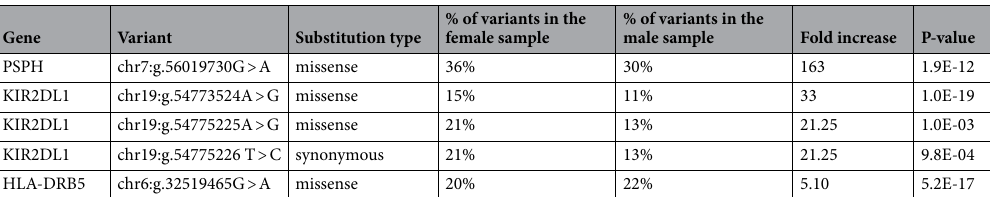
Table 1. Top 5 variants with the highest fold increase and statistical significance in the Serbian population sample compared to Europeans and their sex representation. Statistical significance was determined by the one-tailed Fisher’s exact test with total frequencies from all 1kGP populations and after the Bonferroni correction the P-value threshold was P < 0.002.